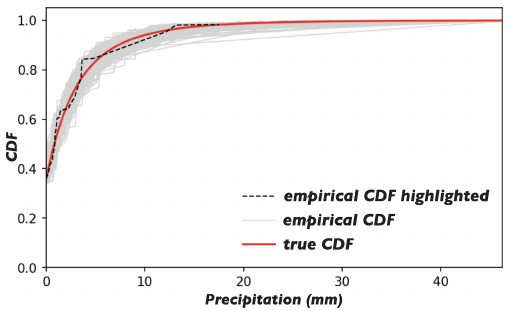
Figure 1. Light grey: the empirical CDFs obtained by linearly join- ing ( r k , u k ) points after the two quality control steps, with one CDF highlighted by the black dashed line. Red: the true rainfall CDF. Note that the empirical CDFs shown here are computed from the synthetic data as described in Sect.